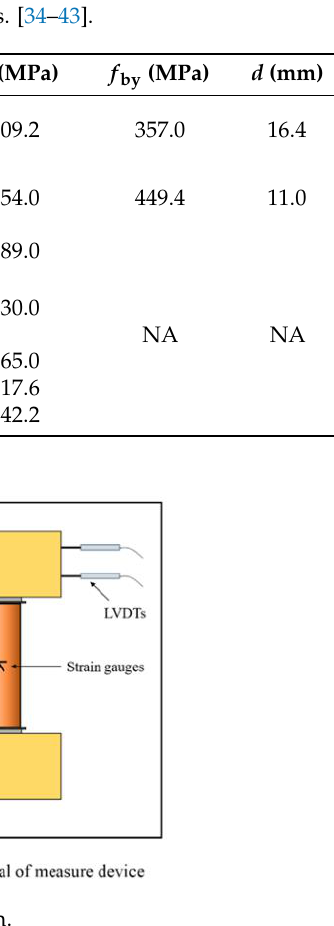
Figure 1. Experimental device and layout of the specimen. Table 1. Specifications of the tested CFST columns in Refs. [34–43].